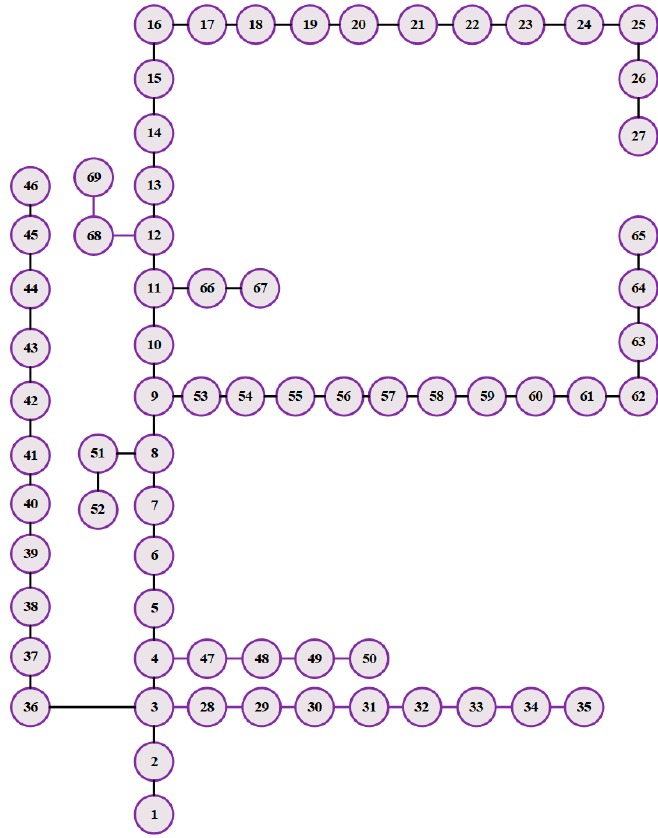
Figure 11. The IEEE 69-distribution system. Table 5. Placement and sizing of D-SVC devices for the IEEE 69-distribution system for Scenario 1.